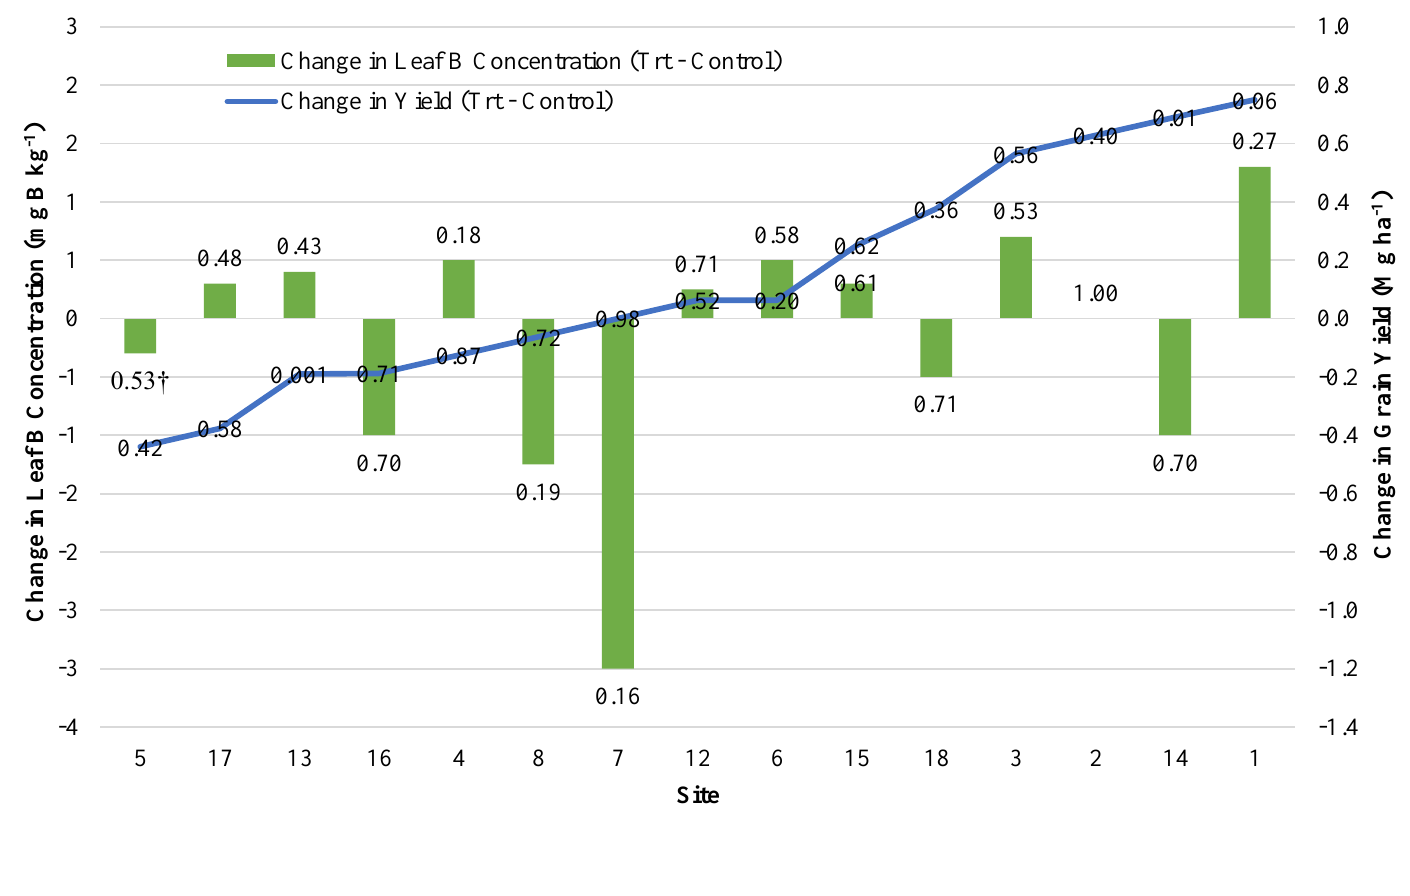
Figure 6. Leaf B concentration (bars) and maize grain yield (line) responses to foliar B application for 15 sites. Data labels on both the line and bar graphs indicate p -values † for mean comparison differences. The correlation coefficient (r) for the relationship of changes in tissue B concentration and grain yield due to foliar B application is 0.2.